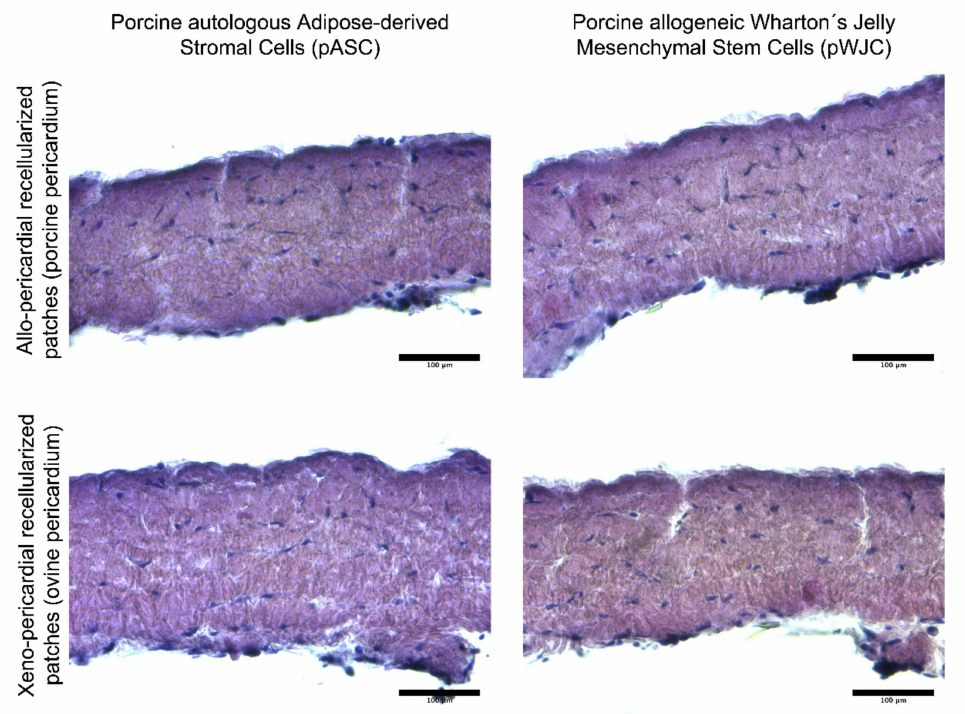
Figure 3. Histological evaluation (paraffin-embedded sections stained with hematoxylin and eosin) of bioreactor-processed implantable patches based on decellularized porcine and ovine pericardia. Newly seeded cells penetrated the entire thickness of decellularized tissue after being cultivated in dynamic conditions for 5